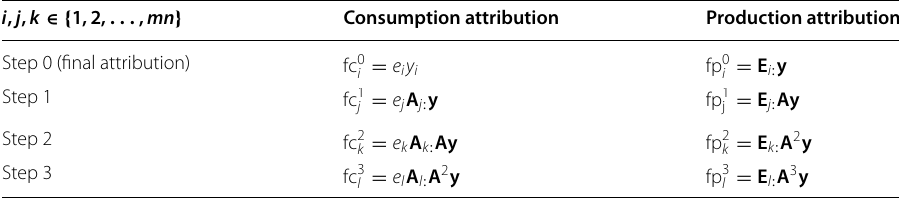
Table 5 Emission attribution for consumption and production side. Source : Skelton et al. (2011) i , j , k ∈ { 1,2, ... , mn